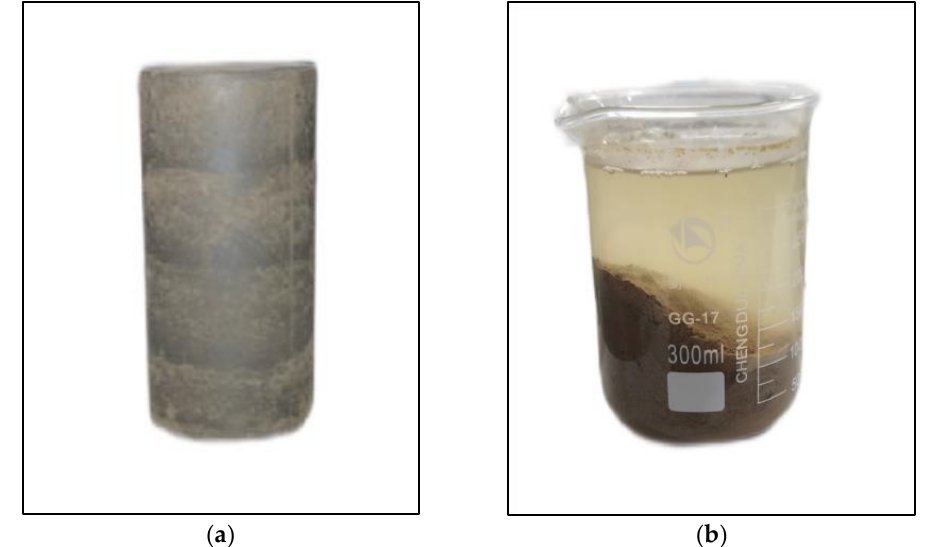
Figure 22. Morphology of the solidified silt with a w g of 0% during dry-wet cycles: ( a ) N dw = 0, ( b ) N dw = 1.